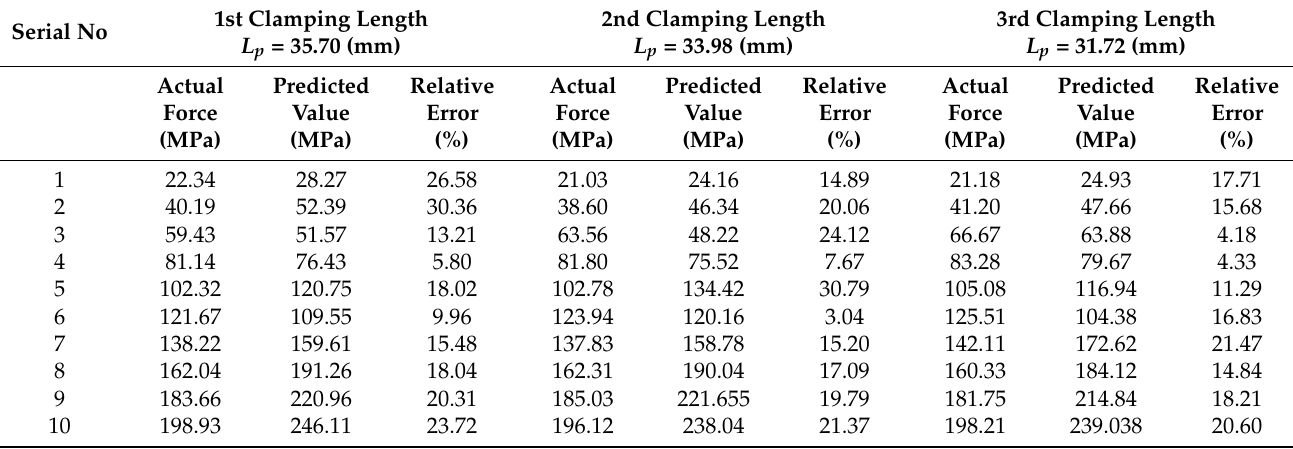
Table 7. Measurement results of axial stress based on the conventional acoustoelastic method.